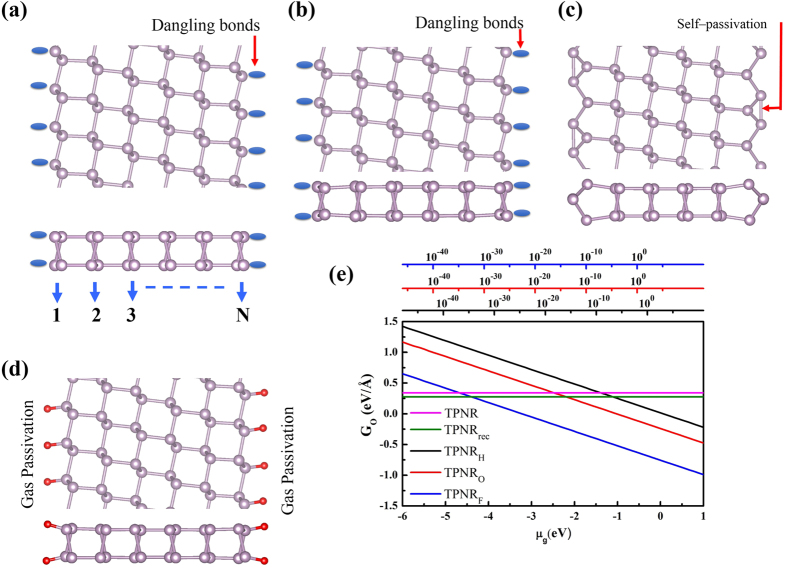
(a) Schematic illustration of TPNRs (b) relaxed structure of 6-TPNR, (c) relaxed structure of 6-TPNRrec (d) schematic illustration 6-TPNR with gas atom passivations, red balls represents the H,O and F gas atoms, (e) free energies versus chemical potential for 6-TPNR, 6-TPNRrec 6-TPNRH 6-TPNRO and 6-TPNRF. The alternative top axes show the pressure, in bar, of molecular gas corresponding to the chemical potentials at room temperature (T = 298.15 K).